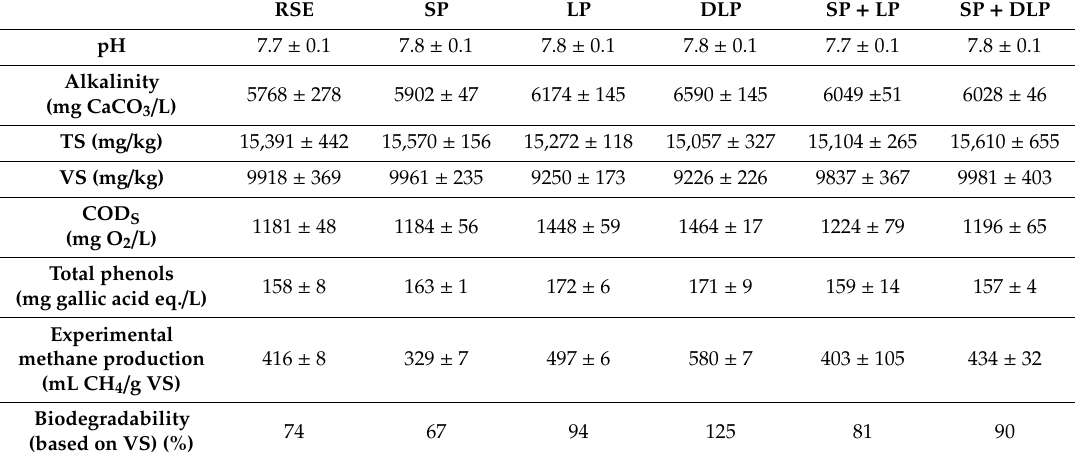
Table 2. Analytical characterization of e ffl uents from the anaerobic digestion process at the end of